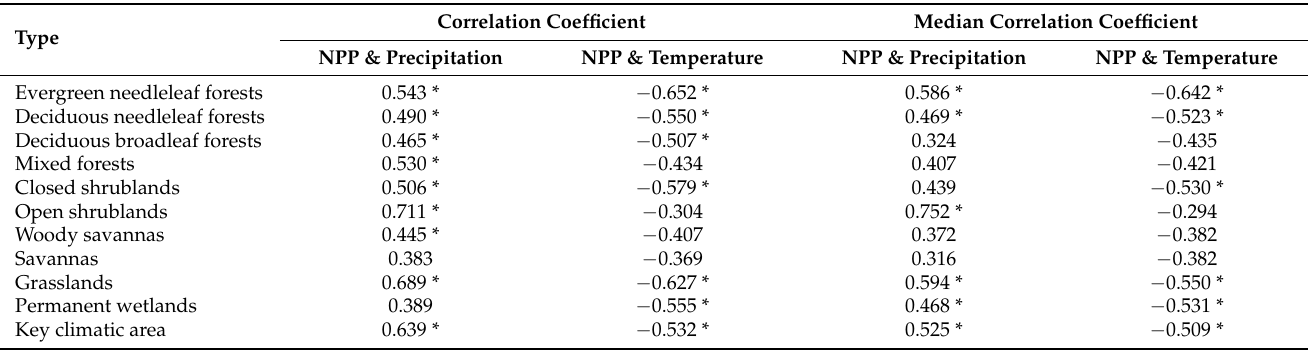
Table 2. The correlation coefficients and their medians between NPP and precipitation and tempera- ture for different types of natural vegetation in the key climatic